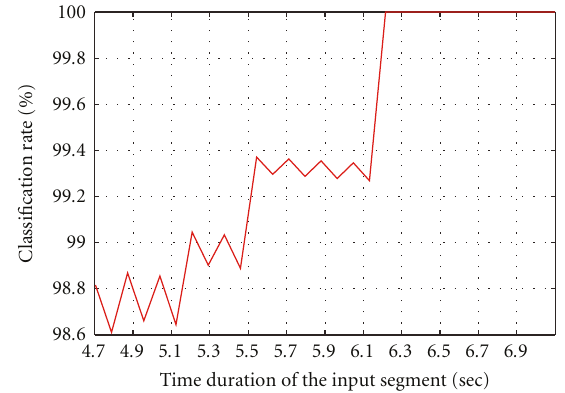
Figure 12: Classification rate as a function of the time duration of the input